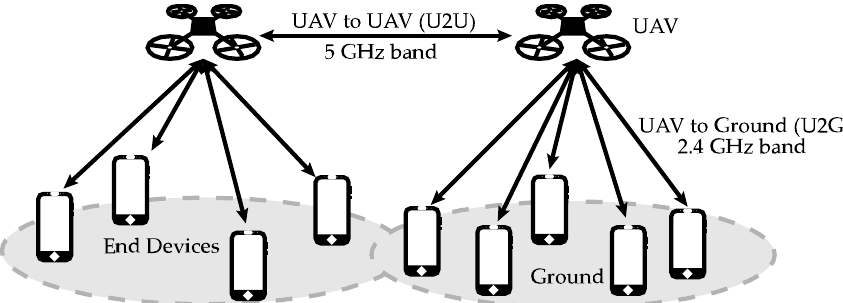
Figure 1. An example of communication links in a FANET using the 5 GHz band for U2U communication and the 2.4 GHz band for U2G coverage.